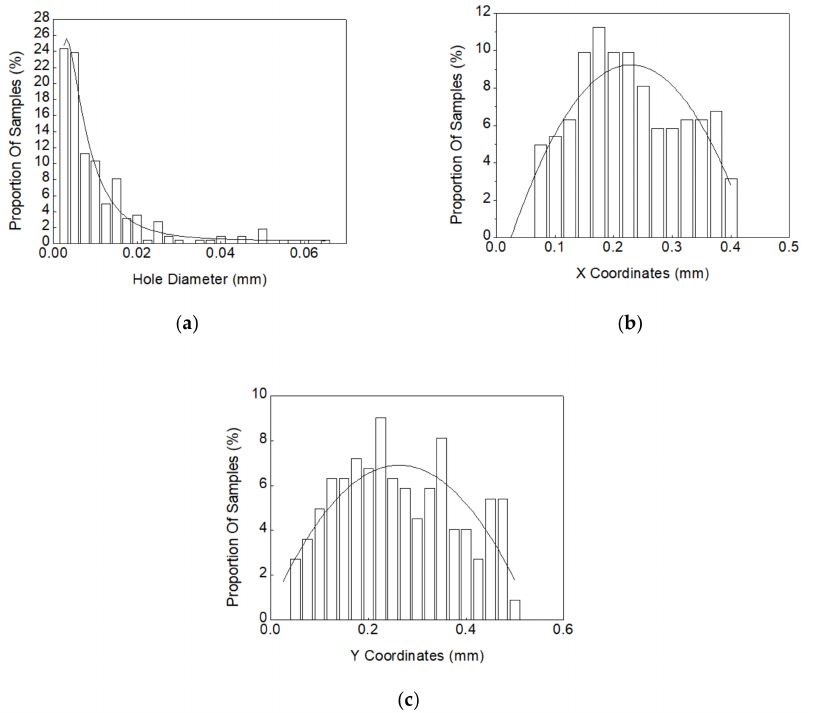
Figure 4. Statistical curve-fitting of void size and location distributions in solder joints: ( a ) lognormal distribution curve fitting of void diameters; ( b ) normal distribution curve fitting of X coordinates of voids; ( c ) normal distribution curve fitting of Y coordinates of